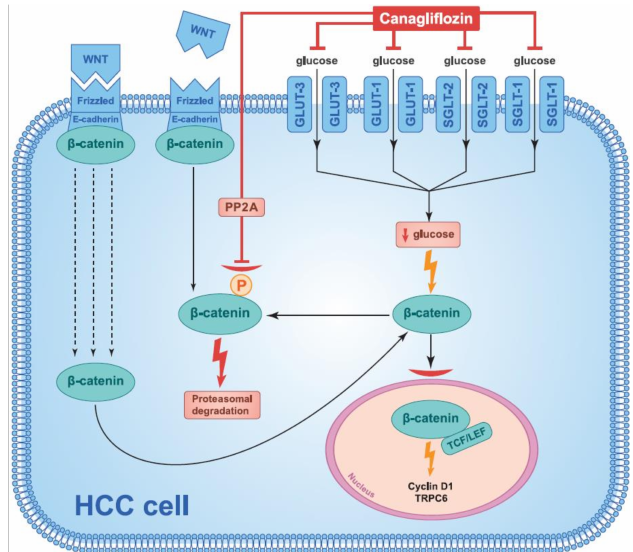
Figure 1. Canagliflozin inhibits β -catenin action and enhances its proteasomal degradation in HCC cells. Canagliflozin blocks glucose influx-induced β -catenin action in HCC cells. Canagliflozin